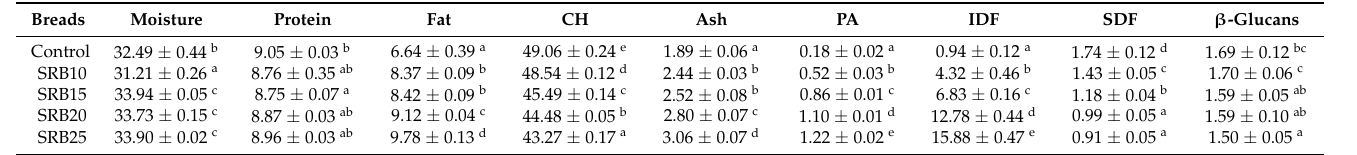
Table 6. Nutritional composition (expressed in g/100 g d.m.) of control and experimental breads formulated with different levels of of